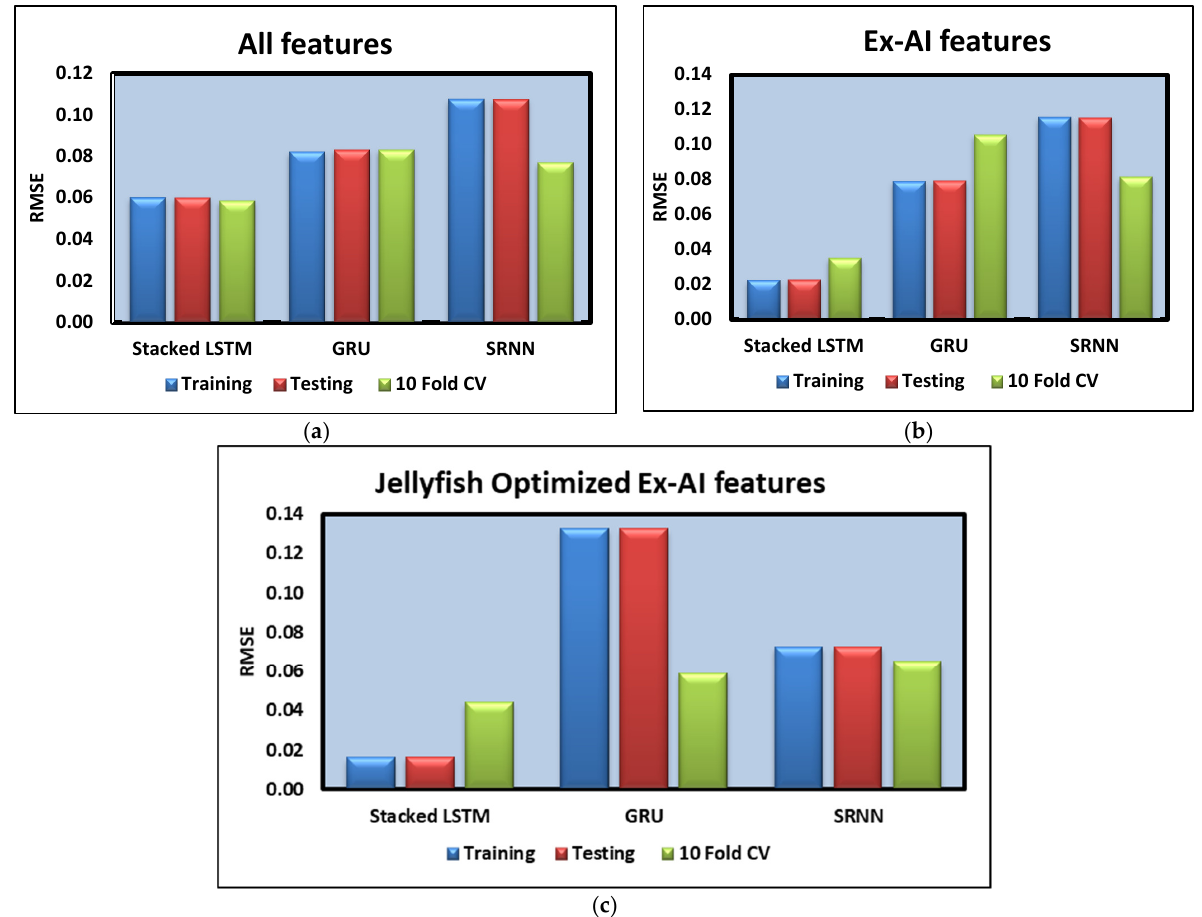
Figure 11. ( a – c ) RMSE values from three models. ( a ) All features. ( b ) Ex-AI features. ( c ) Jellyfish- optimized EX-AI features.